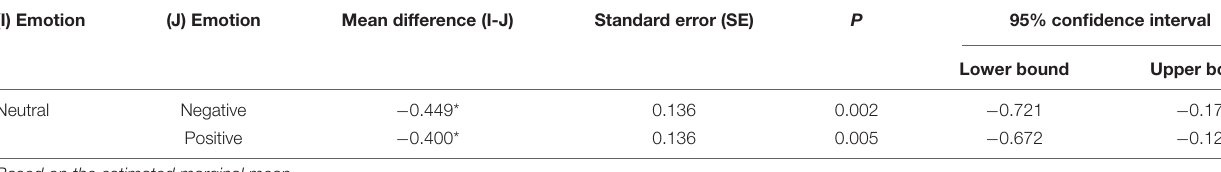
Based on the estimated marginal mean. *The mean difference was significant at 0.05 level. TABLE 5 | Results of simple effect analysis (age ×